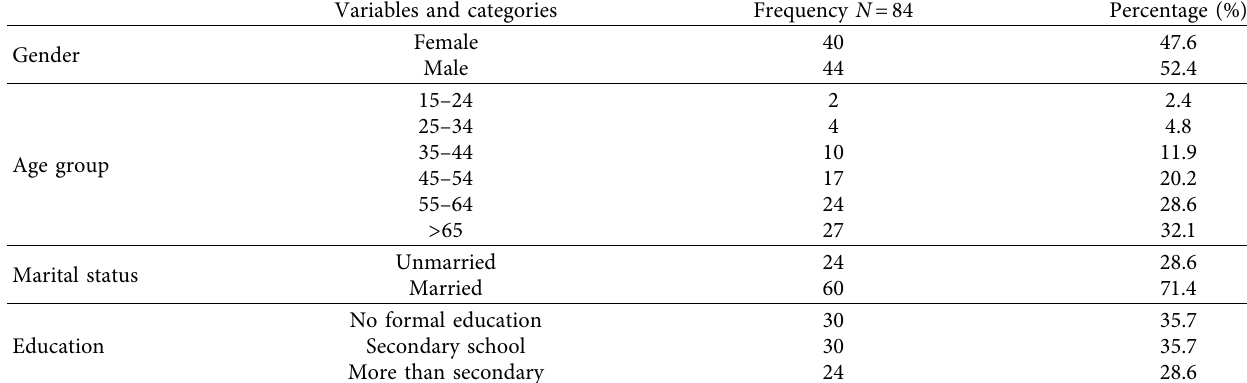
Table 1: Baseline sociodemographic characteristics of stroke patients at TASH and ZMH neurology clinic.